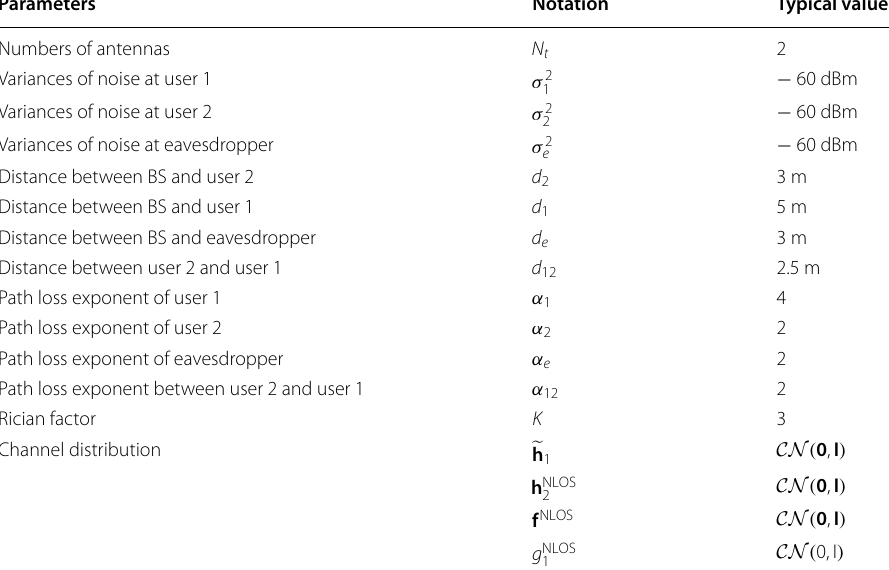
Table 2 Simulation